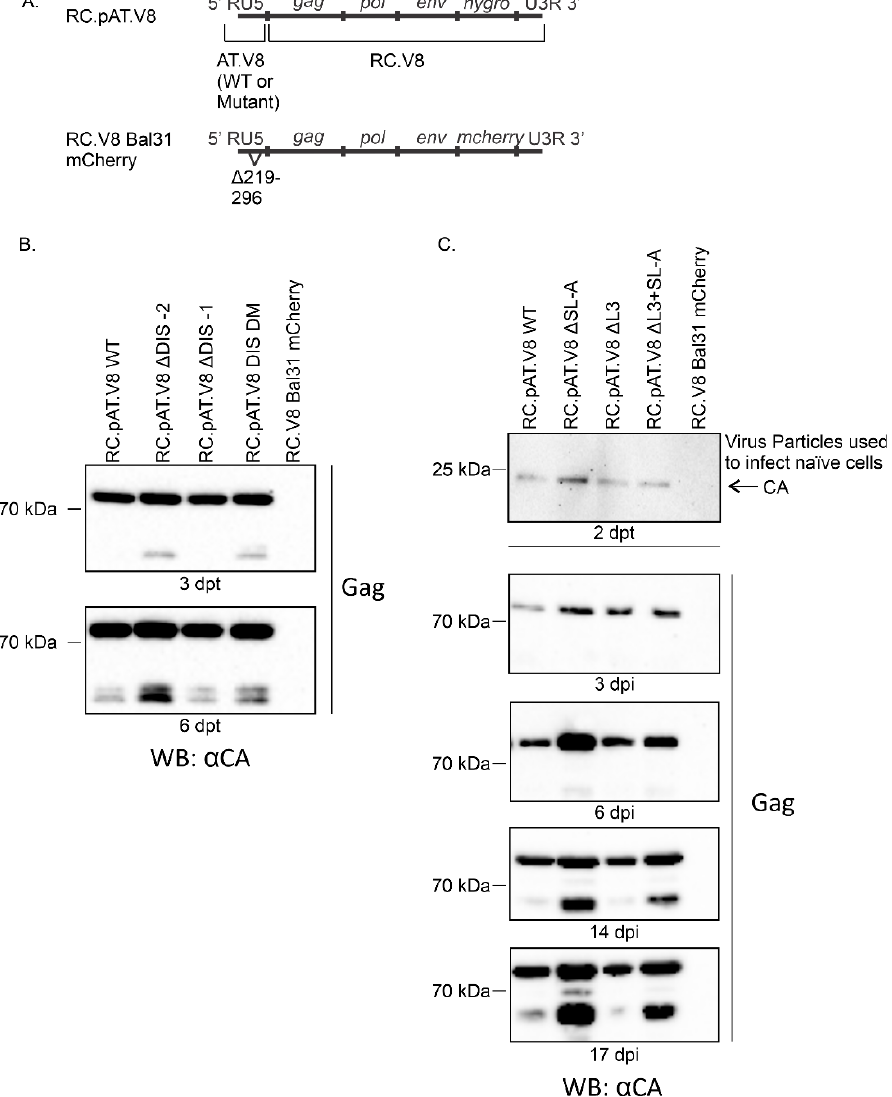
Figure 3. ( A ) Schematic of the constructs used in the infectivity studies. ( B ) Immunoblots of Gag in 50 µg of lysates collected from QT6 cells transfected with RC.pAT.V8 WT, RC.pAT.V8 ∆DIS -2,